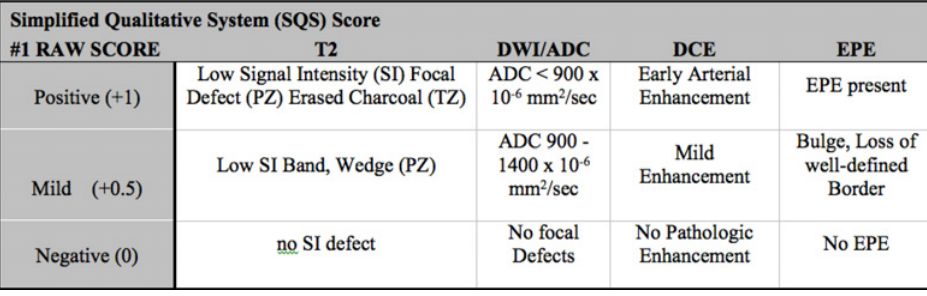
Fig 3. SQS Scoring System, Step 1: Calculate raw score by adding points for each finding listed. Score range is between 0 – 4.